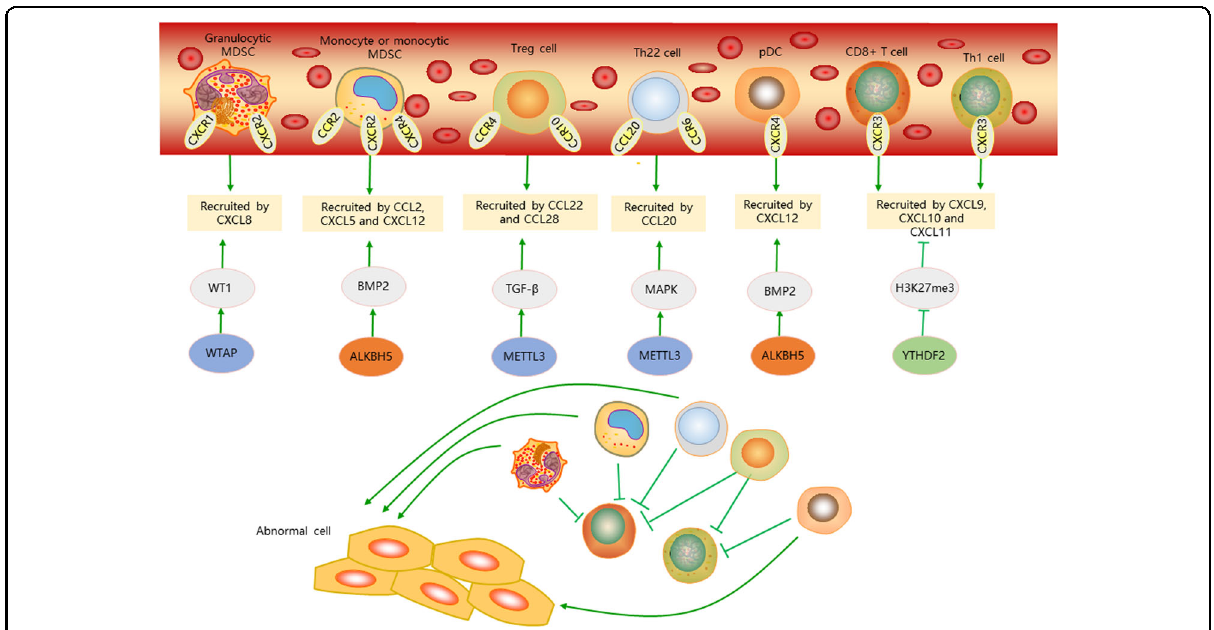
Fig. 4 The m6A regulation of chemokine in immune evasion. The m6A could affect the chemokine functions including pro-tumor effects of chemokines involved in Immune cell such as granulocytic and monocytic myeloid derived suppressor cells (MDSCs), Treg cells, Th22 cells, and plasmacytoid dendritic cells (pDCs), and suppress-tumor immunity by chemokines involved in immune cell including CD8 T cell and Th1